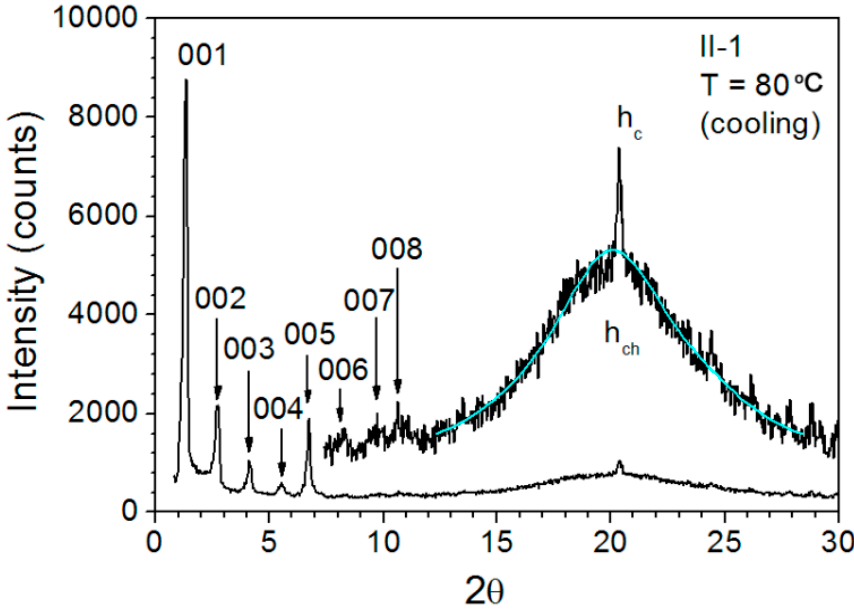
Figure 5. Small-angle X-ray diffraction pattern for polymer II-1 registered on cooling at 80 ° C.